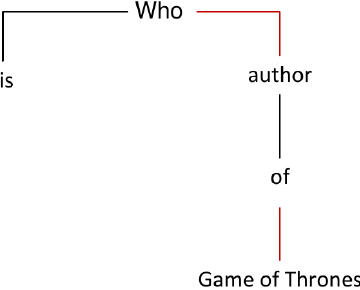
Fig. 3. The minimized dependency tree for question Who is author of Game of Thrones?